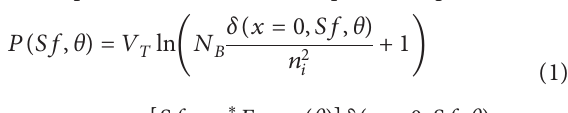
Output Power. Figure 2 plots the power output’s curves according to junction dynamic velocity for different